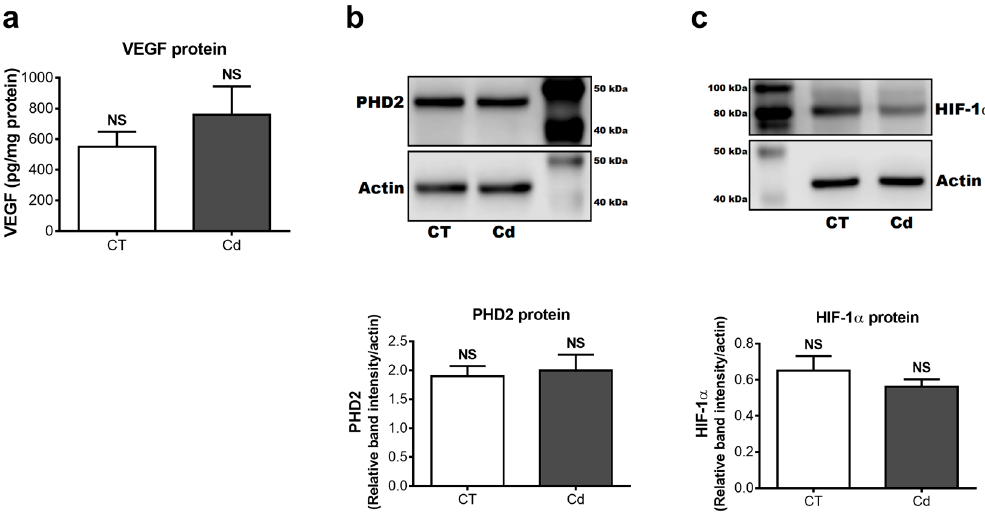
Figure 3. Protein levels of ( a ) VEGF ( p = 0.3389, Student’s t -test), ( b ) PHD2 ( p = 0.7702, Student’s t -test), and ( c ) HIF-1 α ( p = 0.3476, Student’s t -test) in renal tissue from control and Cd-exposed fetuses. ( b , c ) show representative blots of one of six samples from each group, and densitometry. Band intensities were normalized to actin level. VEGF concentration was normalized to protein content. Each sample was run in duplicate. Means ± SEM are shown, n = 6. NS, not statistically significant.